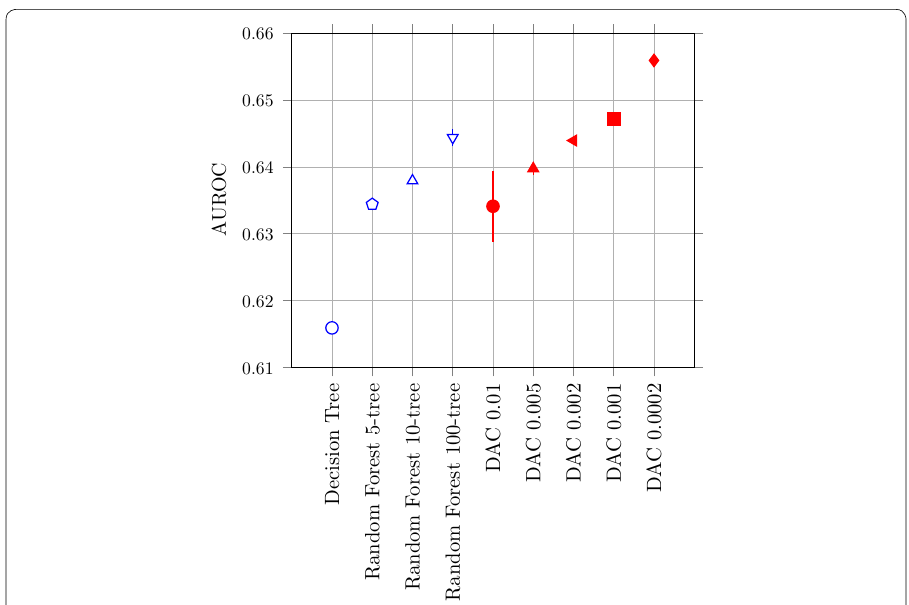
Fig. 4 DAC vs Random Forest. AUROC cross-validated with fivefold on the entire